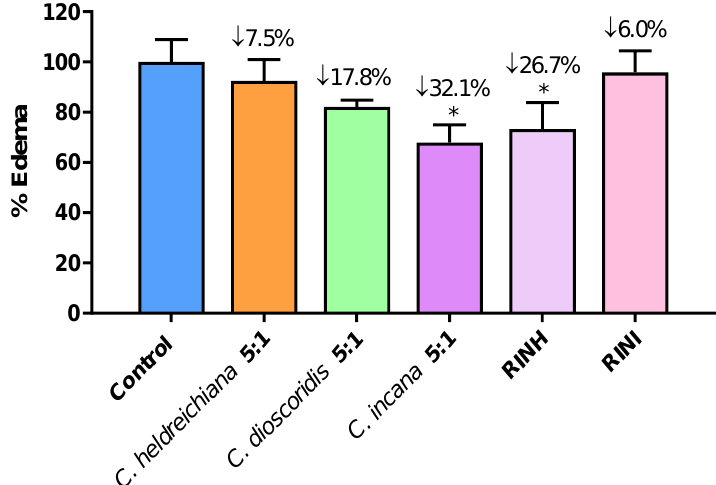
Figure 3. Effect of extracts C. heldreichiana 5:1, C. dioscoridis 5:1, C. incana 5:1 and fractions RINH and RINI on carrageenan-induced mouse paw edema. Each value represents the mean obtained from 6 animals. Significant difference of Control from C. incana group: * p = 0.05 and from RINH: * p = 0.05. [The average weight difference between the injected and un-injected paws for the Control group (100%) is 0.058 g (mean weight of injected/uninjected paw is 0.210 vs. 0.146 g)].